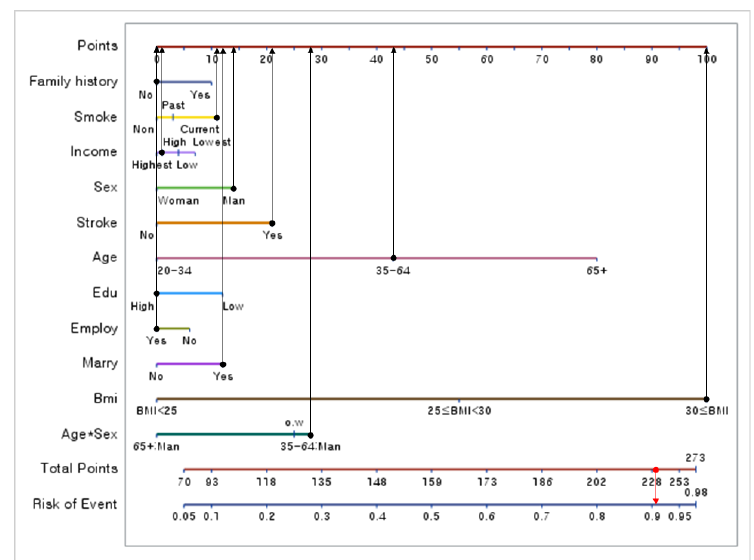
Figure 1. Nomogram result for metabolic syndrome by 11 risk factors.